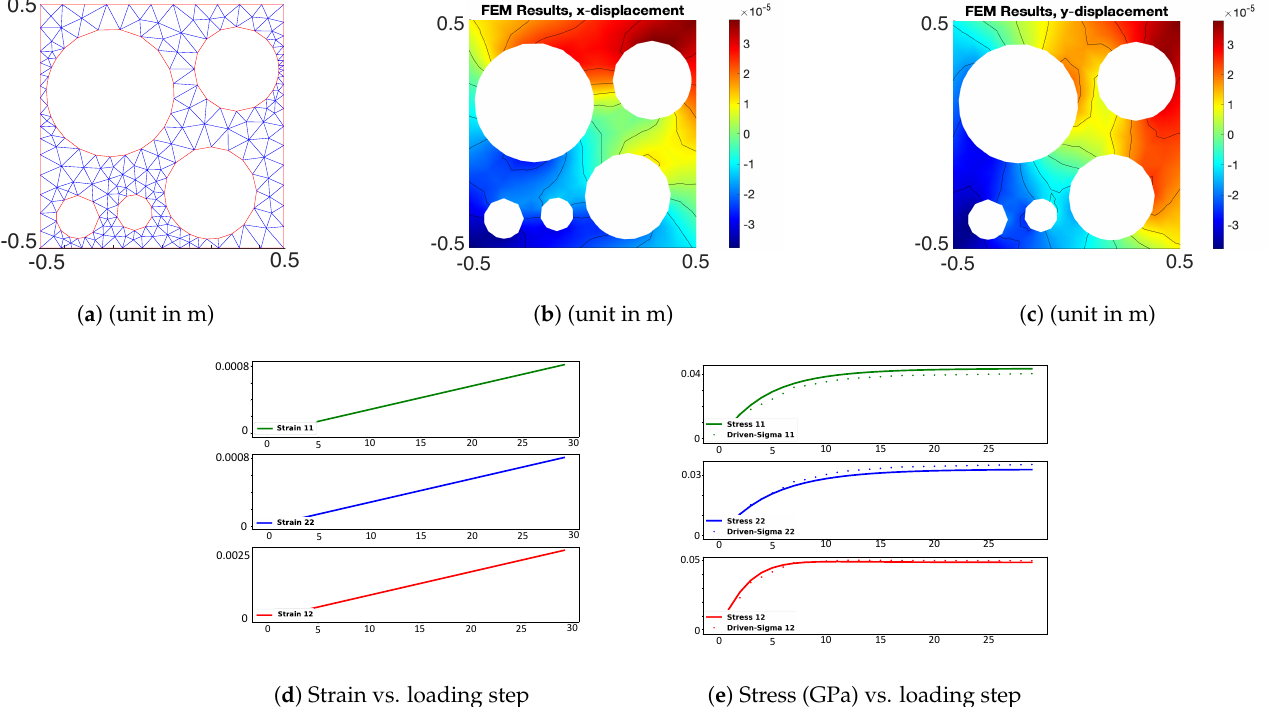
Figure 13. Test 3 for homogenization of nonlinear microstructure ( µ = 55 GPa and λ = 200 GPa), ( a ) FEM mesh, ( b ) X displacement (initial step), ( c ) Y displacement (initial step), ( d ) random generated strain, and ( e ) comparison of the homogenized effective stress and the data-driven